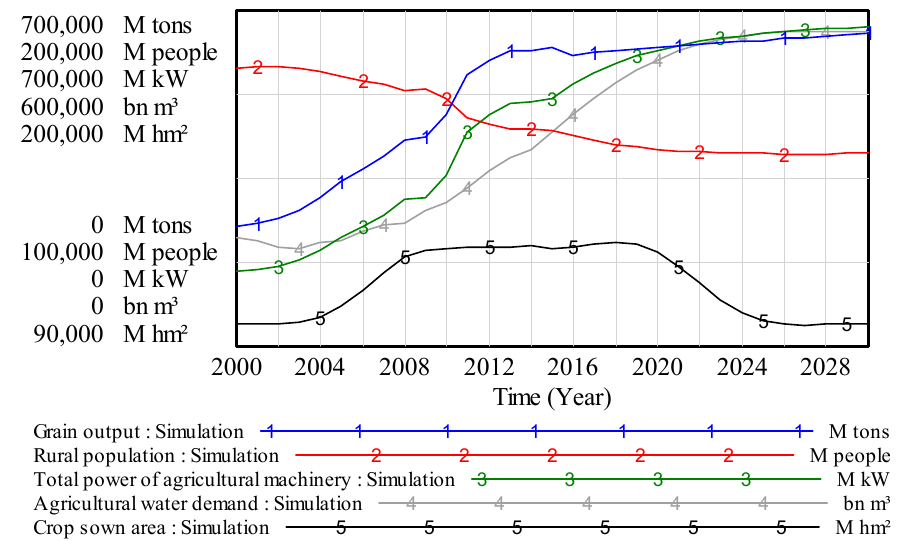
Figure 3. SD model simulation of grain production in Heilongjiang Province.